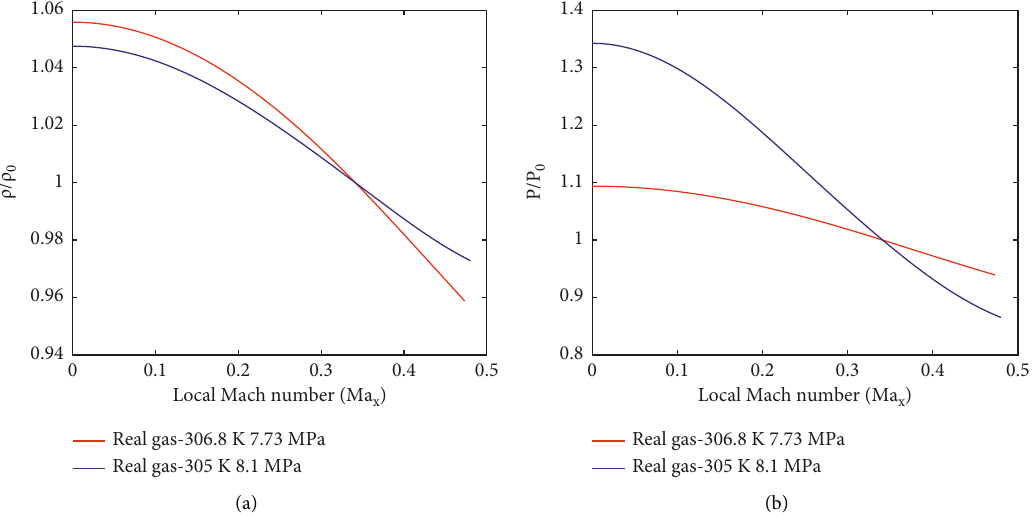
Figure 3: Real-gas cases with variable isentropic exponents at the inlet tip of the impeller. (a) Density and (b)